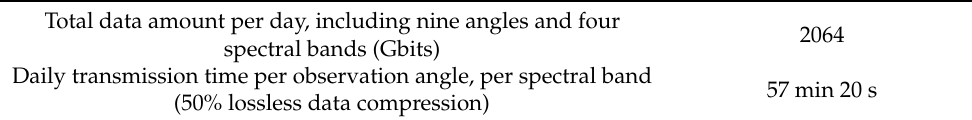
Table 14. Daily data and downlink time for “MISR-like” observation plan. Total data amount per day, including nine angles and